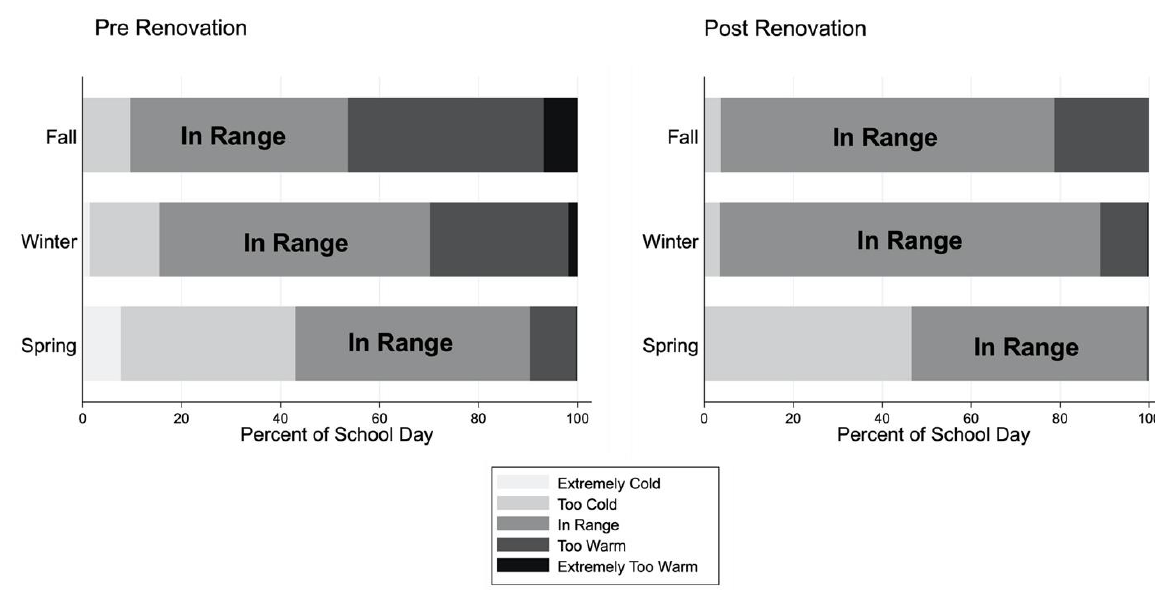
Figure 3. Proportion of indoor temperatures within and outside of range in seven schools with pre- and post-renovation monitoring data. In range indoor air temperatures were determined according to ASHRAE guidelines by season: 68 – 75 °F (20 – 23.9 °C) in fall/winter and 73 – 80 °F (22.8 – 26.7 °C) in the spring/summer. Temperatures were considered to be too cold or too warm if they were below or above the limit of the ASHRAE recommended range for the season by 4 °C or less. Extreme values were defined as values that were more than 4 °C outside of the ASHRAE recommended range. All indoor temperatures included were taken during the school day, between 8:00 a.m. and 4:00 p.m.